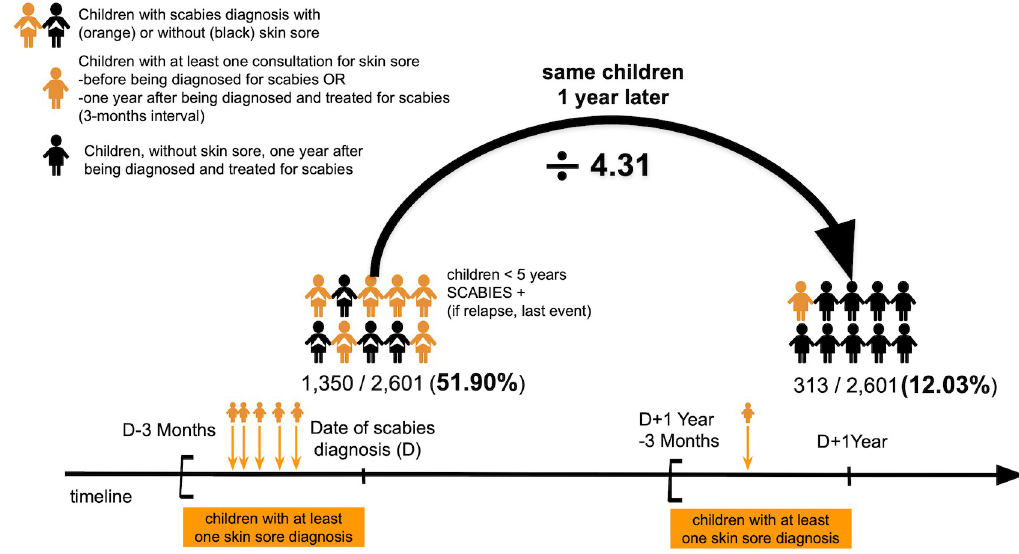
Fig 4. Number of skin and soft tissue infections in children < 5 years in the 3 months preceding scabies diagnosis/ treatment and in the 3 months preceding the 1-year anniversary of scabies diagnosis/treatment.